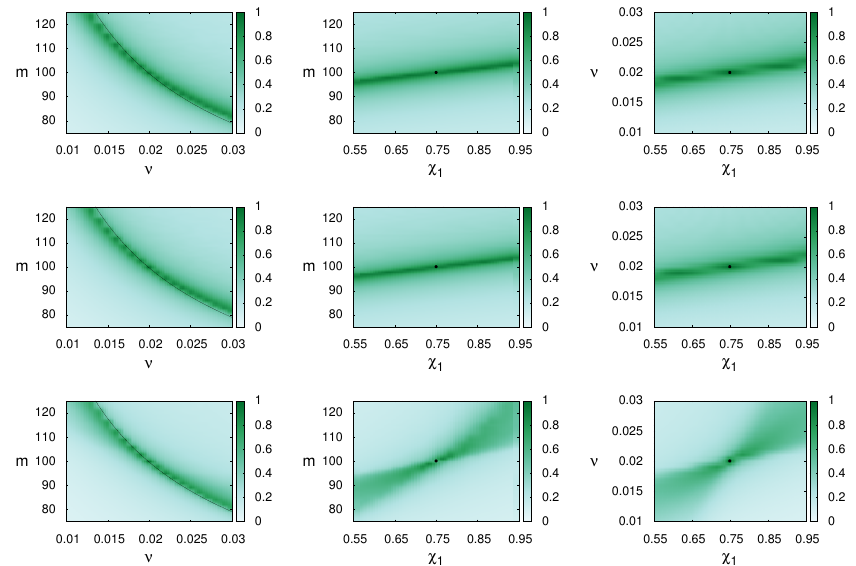
Figure 1. Match values M for two waveforms in the restricted parameter spaces [ m , ν ] , [ m , χ 1 ] and [ ν , χ 1 ] from left to right (the three rows representing SpinDominatedWf-SpinDominatedWf, SpinTaylorT4-SpinTaylorT4, SEOBNRv3-SEOBNRv3 matches). The parameters of the first waveform (the template) are varied, while those of the second waveform (the signal, represented by a dot) are fixed as m = 100 M (cid:12) , ν = 0.02 and χ 1 = 0.75. The other parameters were chosen as f low = 10 Hz, ι = 0.5 The spins are aligned. The black lines on the plots in the first column represent the chirp mass of the signal waveform.